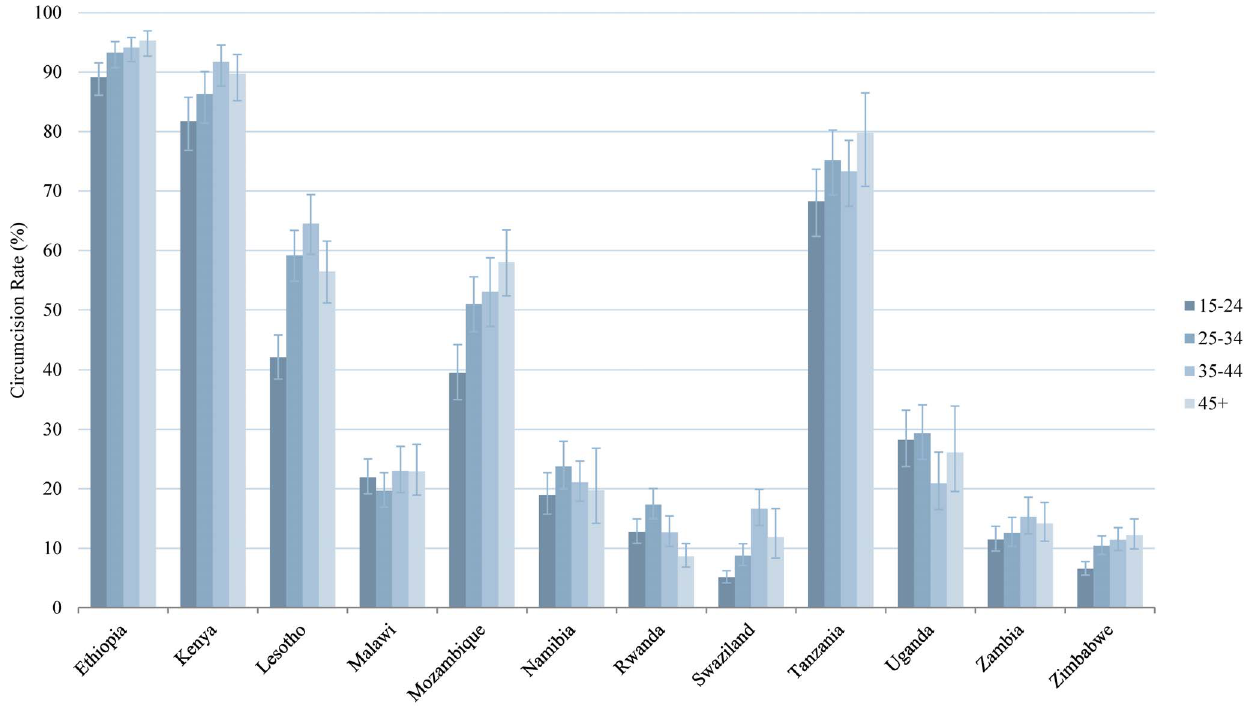
Figure 2. Male Circumcision Rates in Eastern and Southern African Countries, by Age. Percent circumcised among males of different age groups: 15–24, 25–34, 35–44, and 45 + . Error bars represent 95% CI.